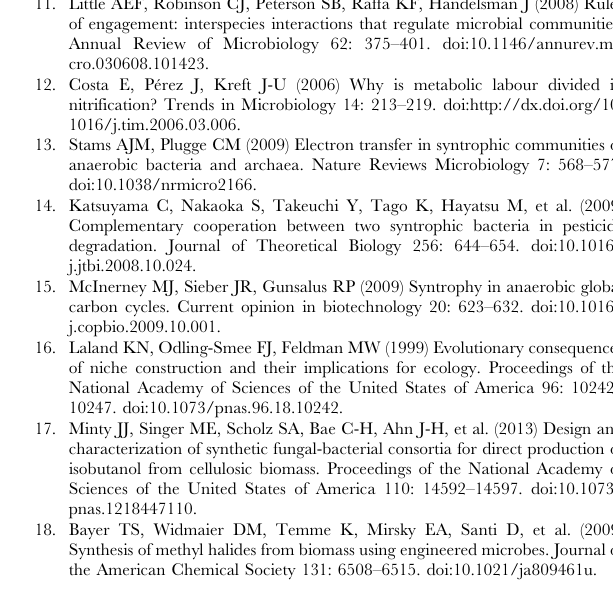
regression line illustrated). Only metabolites that were detected Figure S6 The Goldilocks principle of emergent biosynthetic capacity observed in simple two-species communities. The plot details are as described in Figure 7, using phylogenetic distance rather than functional distance to measure the distance between community members. Phylogenetic distance was calculated according to the divergence in the 16S rRNA gene (Methods). Figure S7 Emergent metabolites predicted by the simple FBA- based protocol (and compare with Figure 4). Predictions were made at the early growth period ( , 1 hr). The black bars represent predictions that were verified also by the stringent FVA-based protocol (and that are therefore included in Figure 4). The magenta bars are additional predictions made by the FBA-based protocol and that were filtered by the more stringent FVA-based protocol. The prevalence of each emergent metabolite predicted by the FVA- and FBA-based protocols is shown in parenthesis (e.g. ethanol was predicted in only 158 community/media configura- tions by the FVA-based protocol but in 170 configurations by the FBA-based protocol). Note that, by definition, FVA-based predictions are a subset of FBA-based predictions. Similarly, the number of media in which at least one emergent metabolite was detected for each species composition and with each of the two protocols is listed on the top. Figure S8 Growth advantage in co-culture compared to mono- culture for ( A ) all species in all community/medium settings; ( B ) producers in community/medium settings that exhibited emergent biosynthetic capacity; and ( C ) partners in community/medium settings that exhibited emergent biosynthetic capacity. ( D )